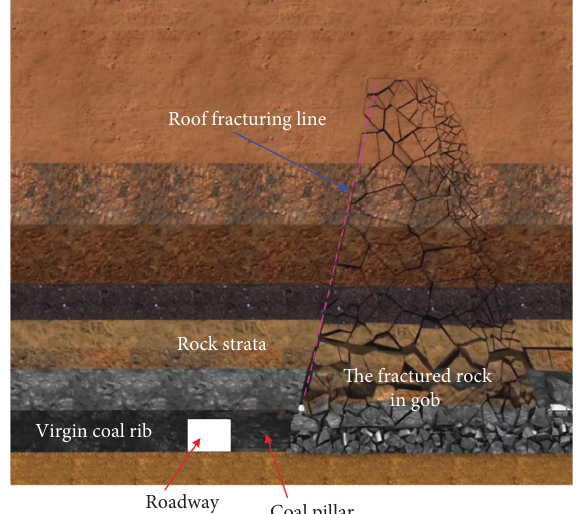
Figure 9: A novel approach for improving the stress environment of the